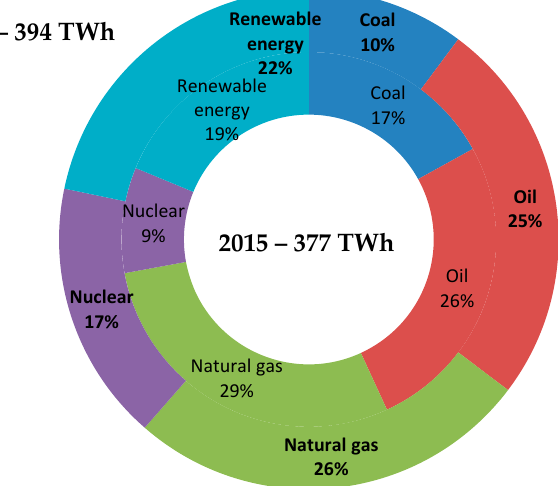
Figure 3. Structure of primary energy mix in 2015 and 2030, Source: Own research based on National Energy Regulatory Authority (ANRE) data [20].